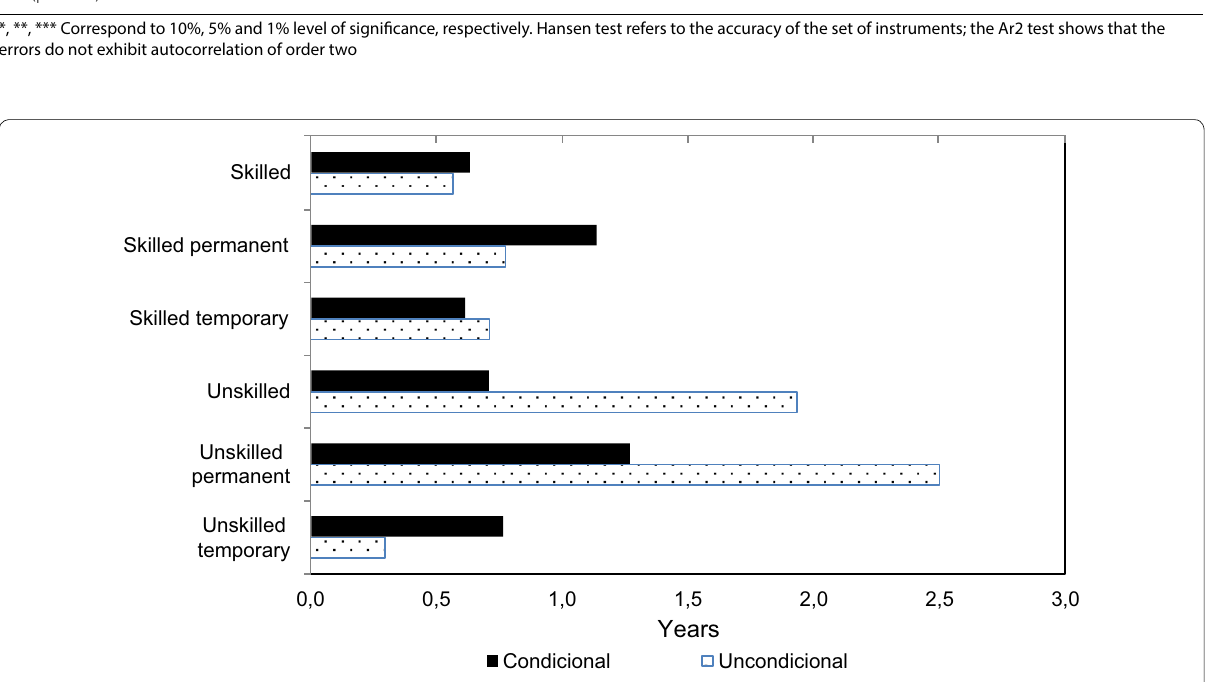
31 Before 2006, Pereira underwent a strong reduction in the rate of participa- tion related to the stream of remittances from Spain and the United states. This labour supply shock, well documented in Colombia (see, for example, Arango and de la Mata 2015), might produce this kind of reaction in real